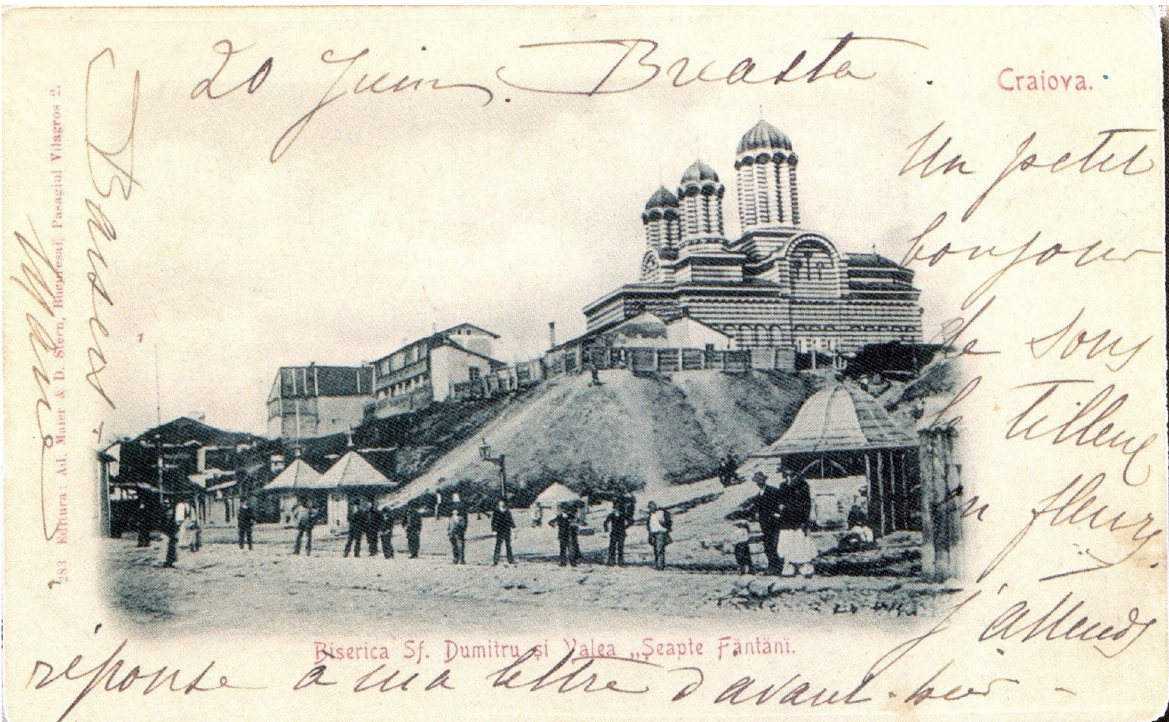
Fig. 5. The Valley of 7 Wells in 1901 ( Buce-Rădu ț